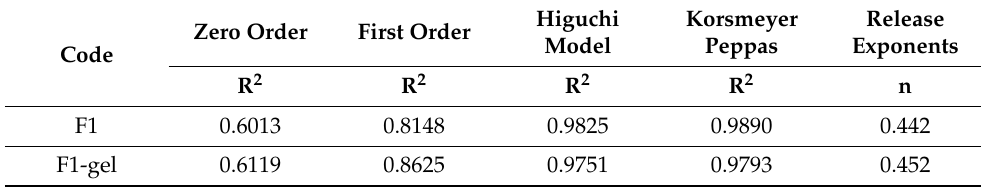
Table 3. Release kinetics mechanism of DSM-loaded NE (F1) and F1-gel.